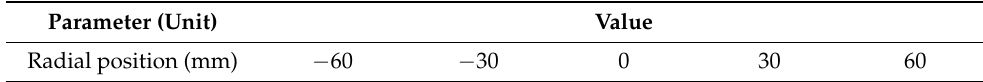
Figure 9. IEMS Sensing unit position. Table 4. Radial position of IEMS sensing unit at middle axis and center position.